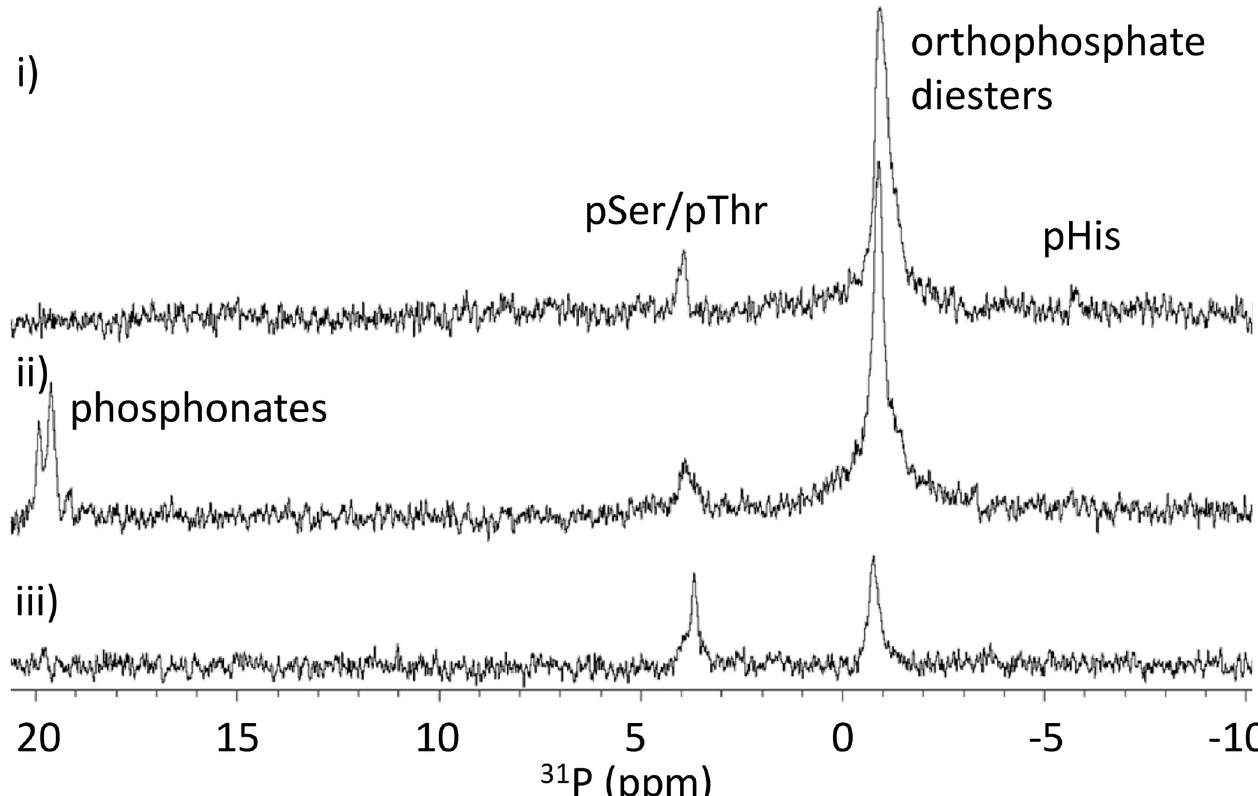
Fig 5. 31 P NMR spectra of proteins from 16HBE14o- cell lysate after trypsinization and desalting. i ) Proteins from the 16HBE14o- cell lysate at pH 10.8 prepared as Fig 3; ii ) Same sample after buffer exchange and treatment with trypsin, at 37˚C for 16 h at pH 8.0; iii ) Same sample after desalting. Signal assignments have been made using literature chemical shift values